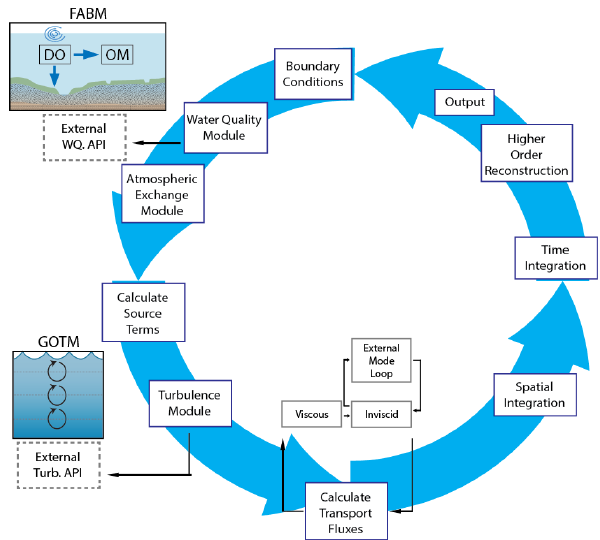
Fig. 4. TUFLOW-FV FABM-AED Model system time-step loop